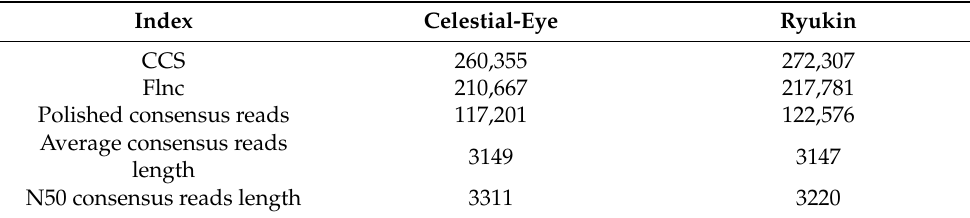
Table 1. Summary information of full-length transcriptome